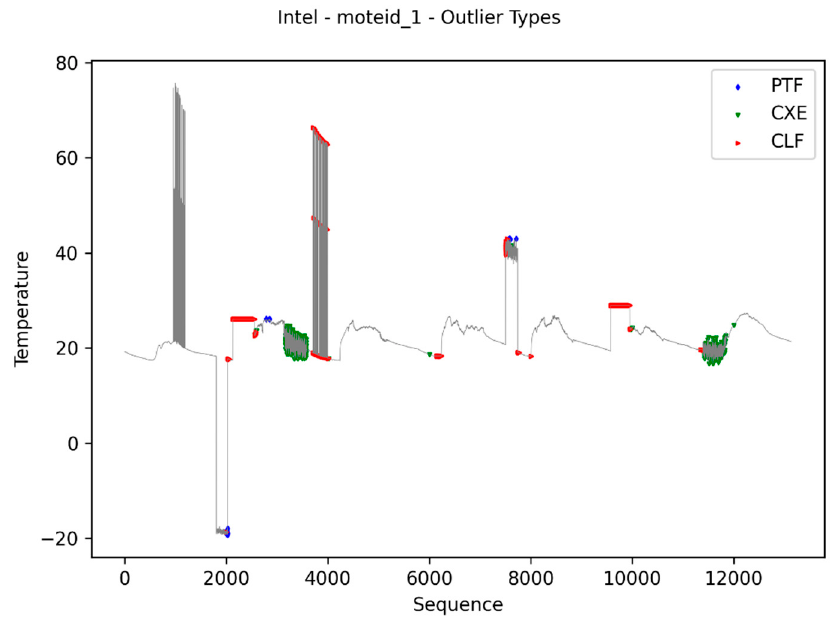
Figure 4. Output fault/outlier type.